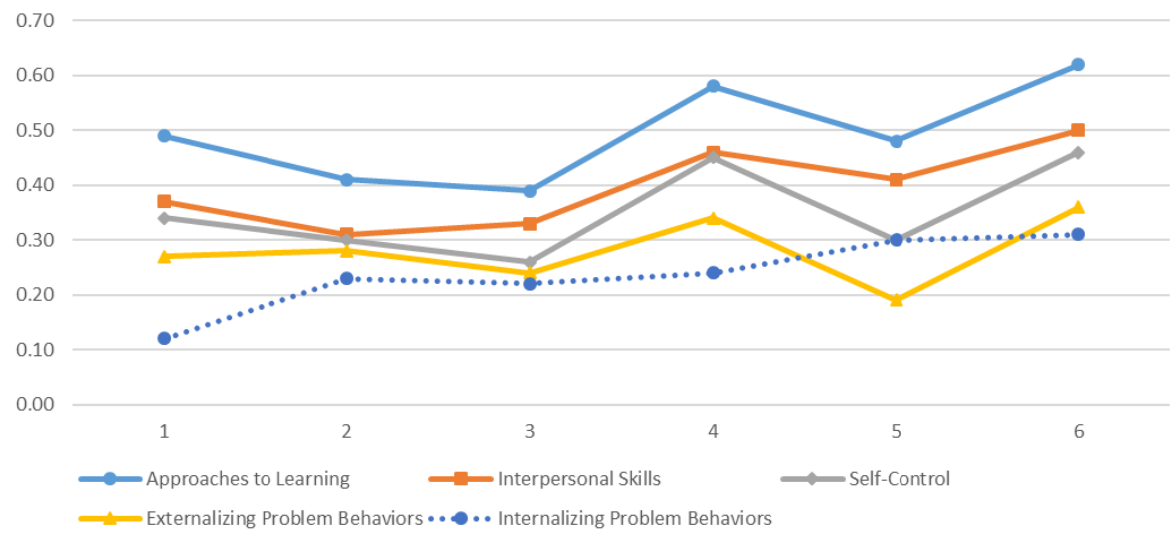
Figure 2: SES gap in social and behavioral